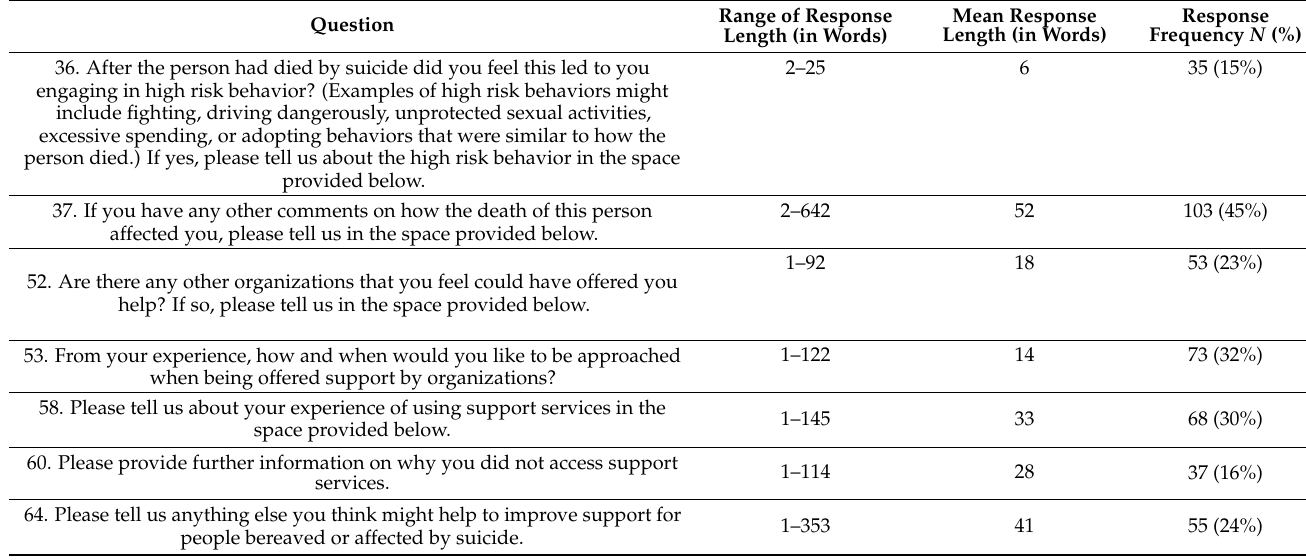
Table 1. Free-text questions and response